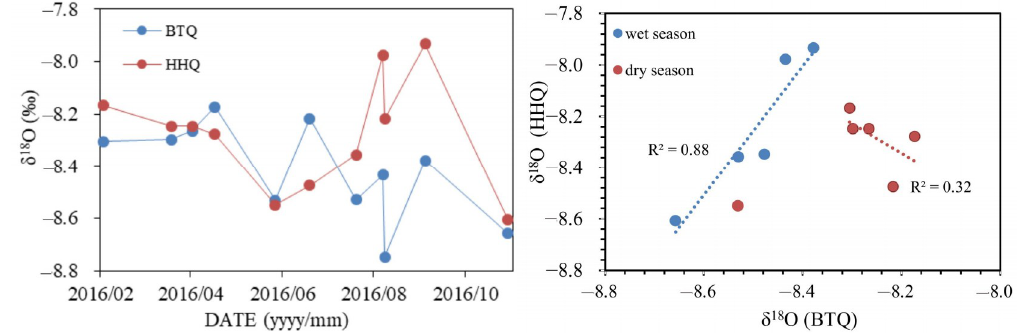
Figure 7. The temporal variation of δ 18 O values in springs and the relationship of δ 18 O values in BTQ and HHQ.